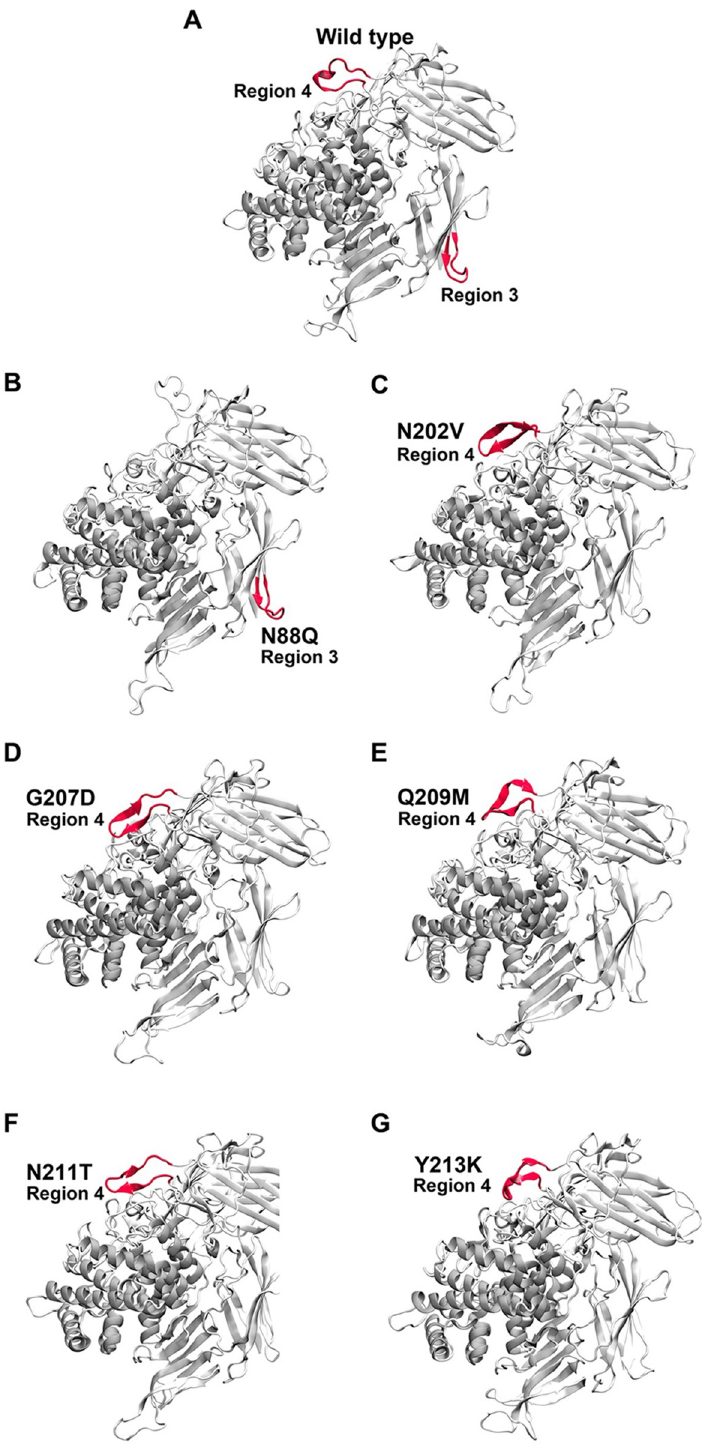
Fig 5. Overall structures of the wild type (A) and designed mutants (B-G) after simulations at 343K show the increased β -sheet structures in region 4 of N202V, G207D, Q209M, N211T and Y213K mutants.